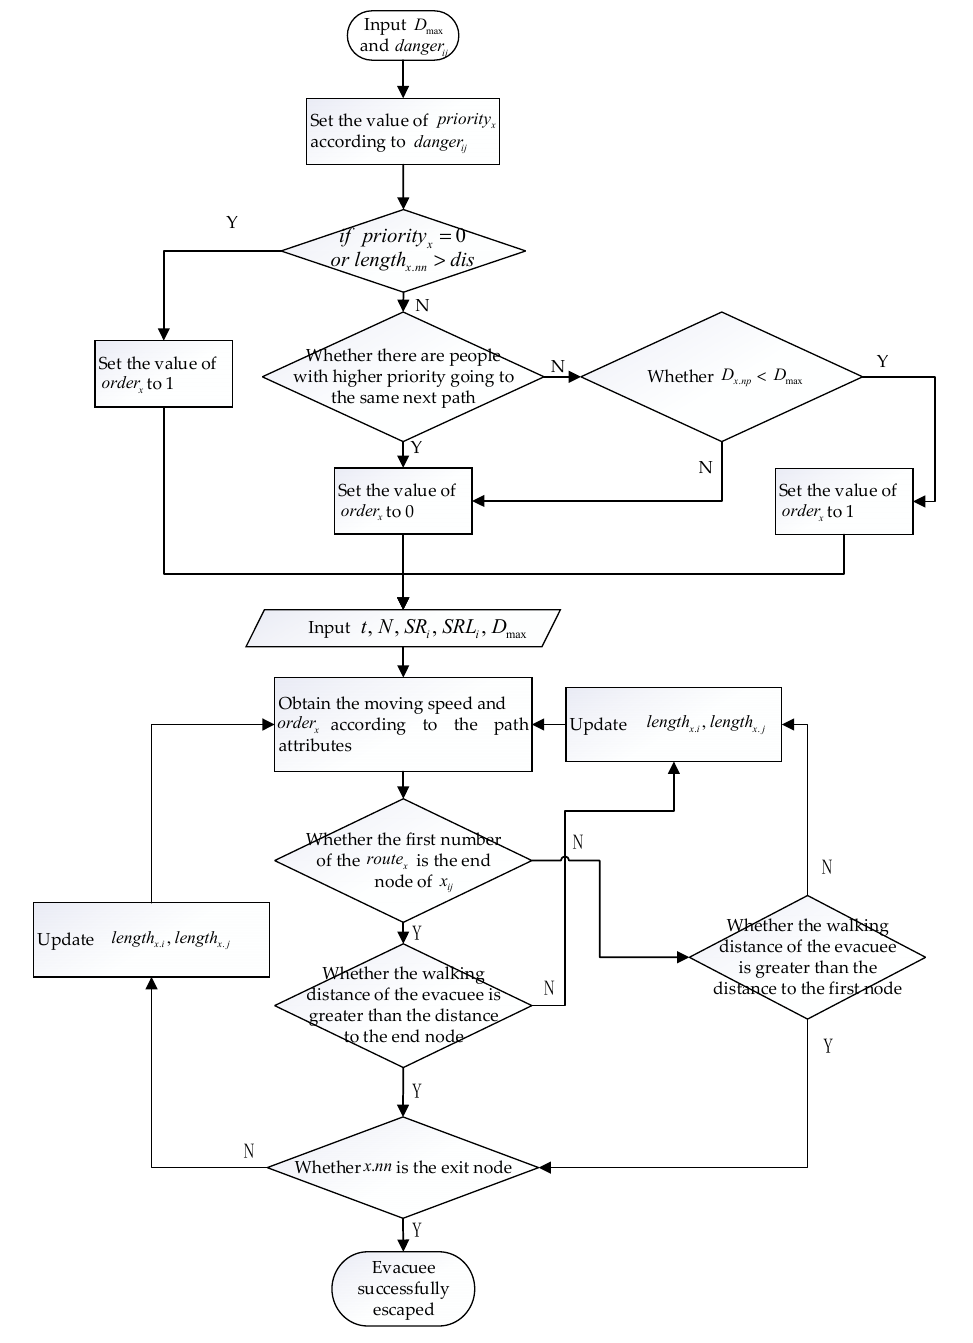
Figure 11. Flow chart for priority evacuation model.